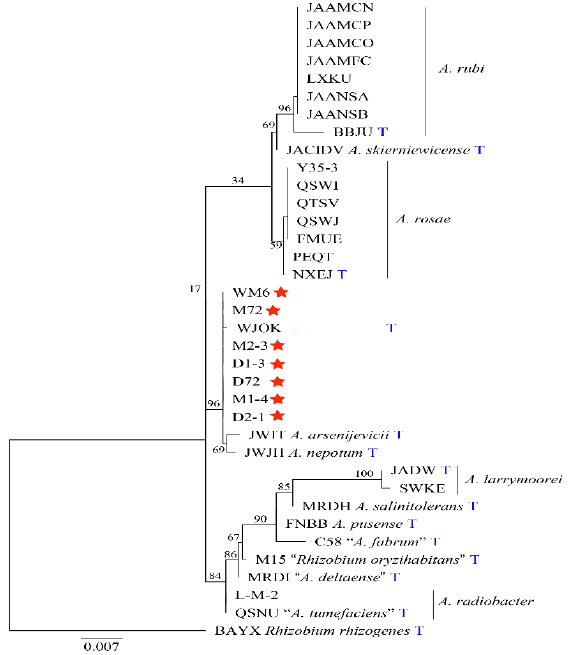
Figure 5. A phylogenetic tree inferred from combined analysis of 16S rDNA gene sequences for a number of species selected from Agrobacterium and Rhizobium . Bootstrap support values over 50% for maximum likelihood (ML), and the Bayesian posterior probabilities are based on 1000 bootstrap replicates. Ex-type strains are marked by an asterisk. The tree was rooted to Rhizobium rhizogenes . “T” stands for type strain.